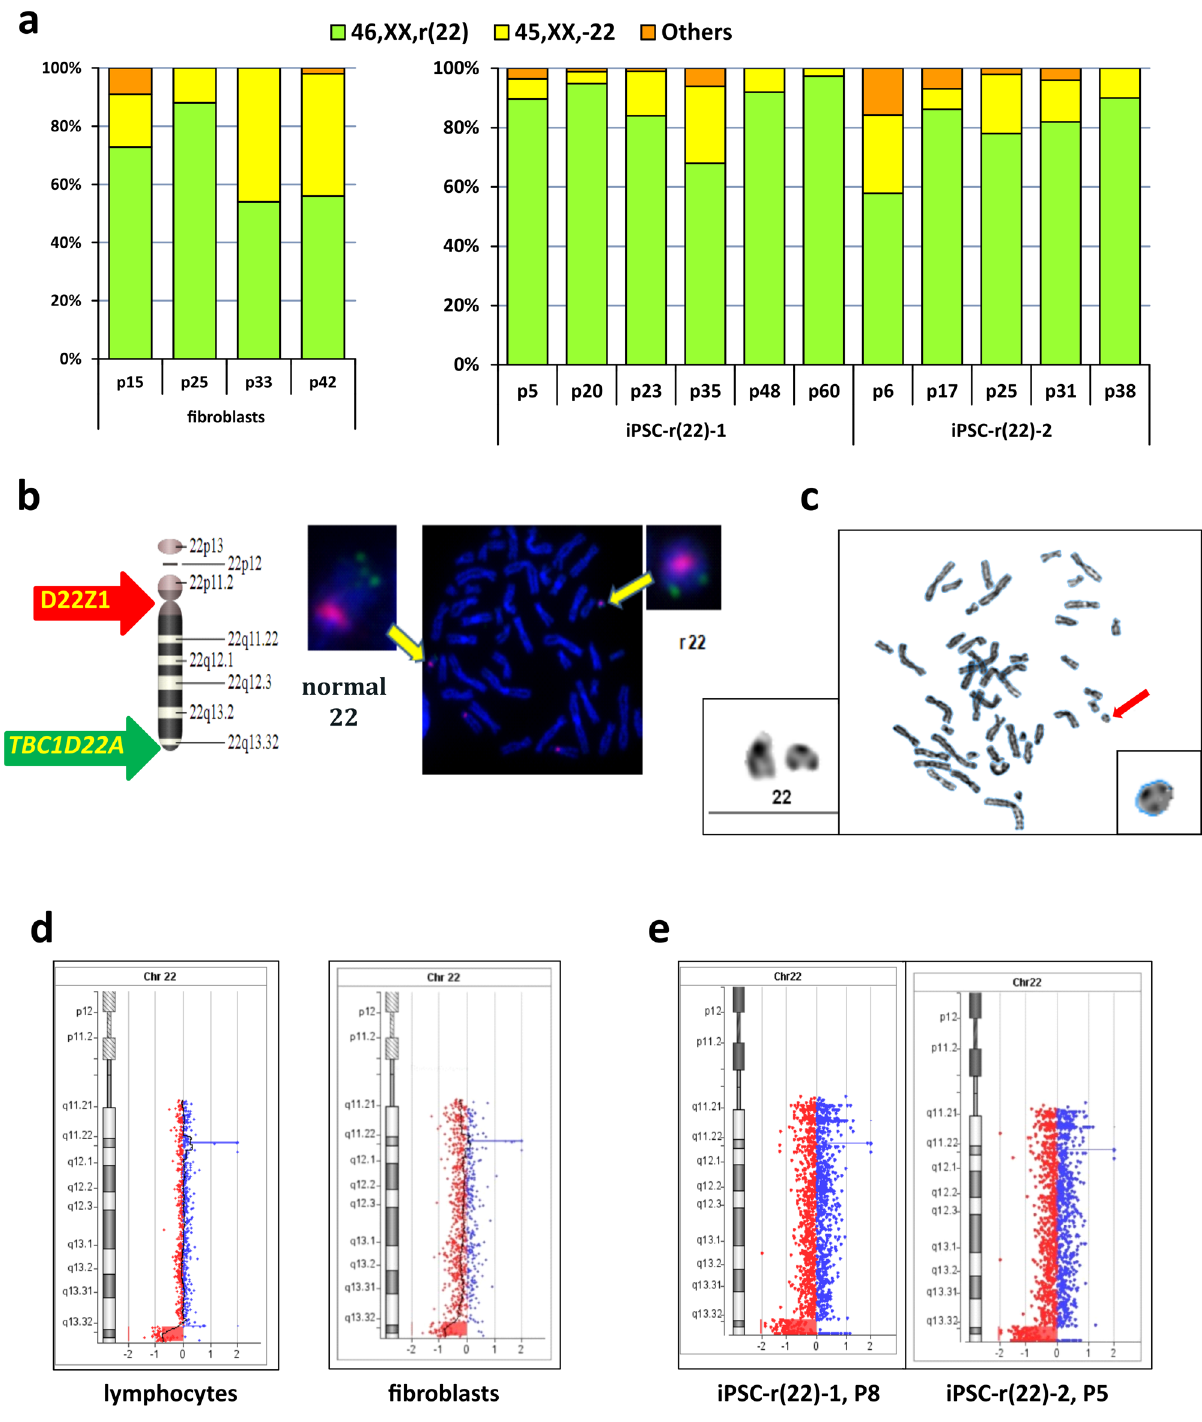
Figure 4. Results of GTG and molecular karyotyping of cell lines with r(22). ( a ) Karyotype rates in fibroblasts (left) and iPSC lines (right) at different passages. ( b ) FISH analysis showing the r(22) morphology and approximate positions of the FISH probes on chromosome 22 (red: centromeric probe 14/22, green: unique gene TBC1D22A (22q13.33), located outside the deleted region) [ISIS software (v.5.5), MetaSystems (https ://metas ystem s-inter natio nal.com/en/produ cts/isis/)]. ( c ) Example of metaphase spread with r(22). ( d ) aCGH profile of chromosome 22 with a terminal deletion of 2.024 Mb at 22q13.32-q13.33 in lymphocytes (left) and fibroblasts (right) [CytoGenomics (v. 3.0.6.6) (https ://www.agile nt.com/en/downl oad-agile nt-cytog enomi cs-softw are)]. ( e ) aCGH profile of chromosome 22 in the two iPSC lines iPSC-r(22)-1 and iPSC-r(22)-2 with a stable ring structure [CytoGenomics (v. 5.0.2.5) (https ://www.agile nt.com/en/downl oad-agile nt-cytog enomi cs-softw